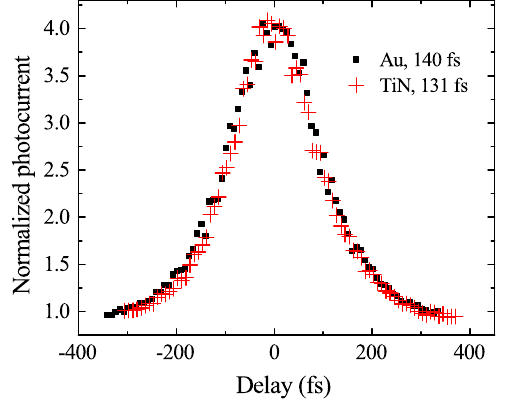
8. Normalized interferometric autocorrelation of